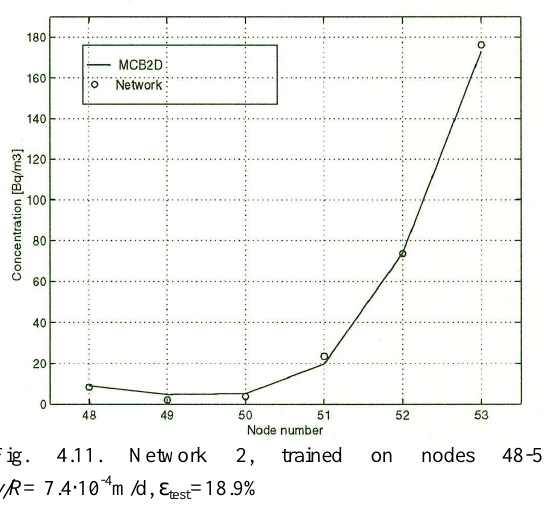
Fig. 4.11. Network 2, trained on nodes 48-53,